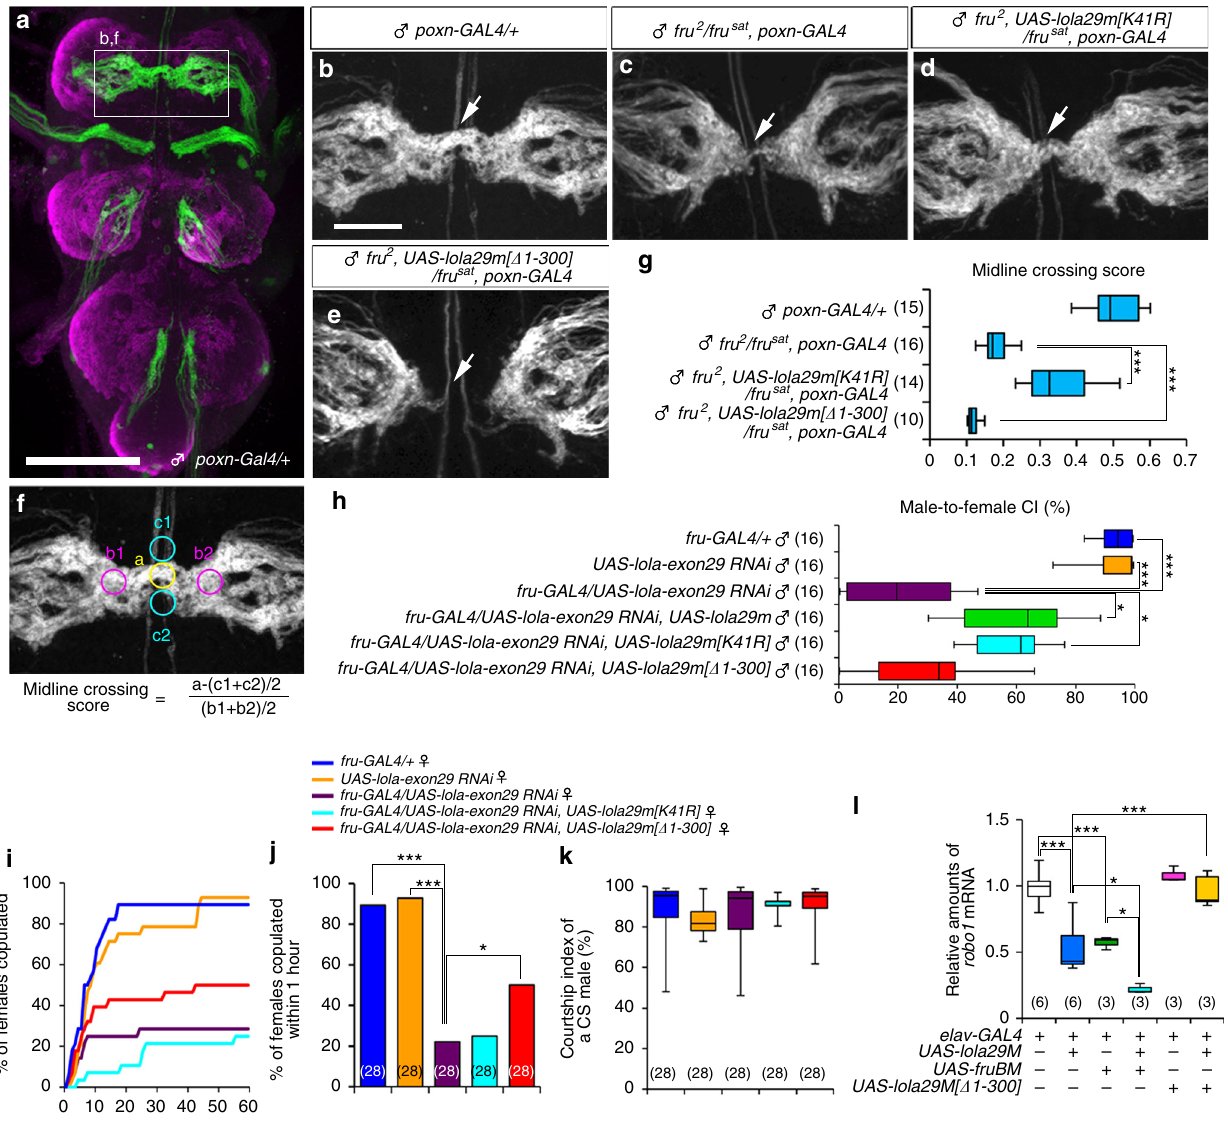
Fig. 4 Lols29F/M are required for mating behavior. a – g Effect of Lola29M or Lola29F-like overexpression on midline crossing of leg sensory afferents. The whole thoracic ganglia are shown in ( a ), and the midline portion is enlarged in ( b – e ). The midline crossing score was calculated with the equation shown in ( f ) with values of fl uorescent intensity measured at fi ve regions, a, b1, b2, c1 and c2, near the midline. g Comparisons of the midline crossing scores among the indicated genotypes. The box plot shows median and 10th, 25th, 75th, and 90th percentiles. Numbers in parentheses indicate the number of scored fl ies. *** p < 0.001 by the Kruskal – Wallis analysis of variance followed by Steel – Dwass nonparametric multiple comparisons. Scale bars: 100 μ m ( a ) or 30 μ m ( b ). h Male courtship activities. lola-exon 29 knockdown suppressed male courtship toward a female (3rd bar from the top). Overexpression of wild- type Lola29M (4th bar) or truncation-resistant Lola29M (5th bar) partially rescued the effect of Lola29M knockdown but Lola29F-like (bottom bar) had